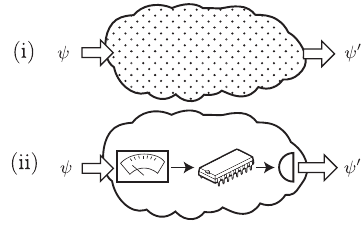
FIG. 1. The quantum device in diagram (i) is not in the quantum domain whenever its functioning can be simulated by a fixed measurement, arbitrary processing of the classical outcome, and a preparation, as shown in diagram (ii). Such devices are called entanglement-breaking